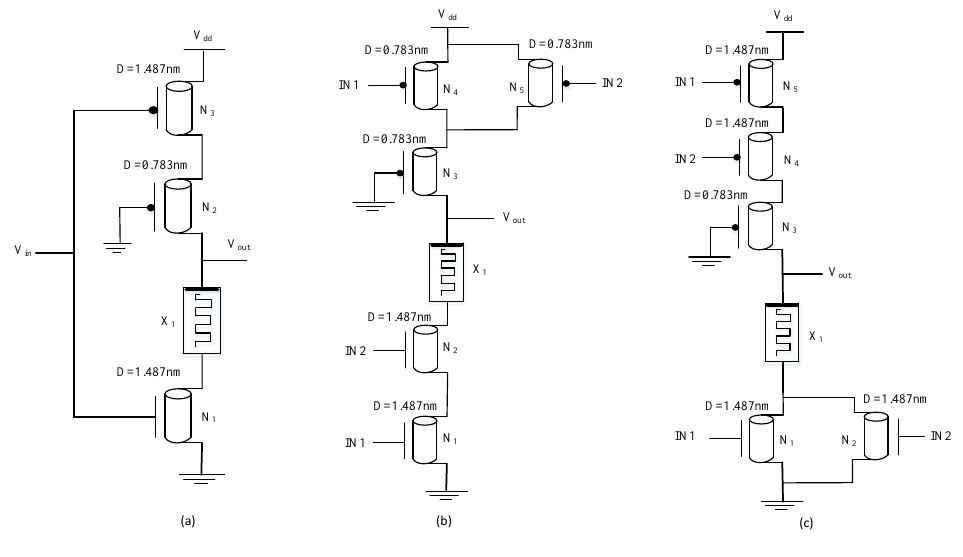
Figure 6. Circuit diagram of ( a ) STI, ( b ) ternary NAND, ( c ) ternary NOR [11]. The ternary CNTFET-RRAM-based Ex-OR gate is designed utilizing the universal property of NAND gates. The circuit schematic of ternary Ex-OR gates using CNTFET- RRAM ternary NAND gates is shown in Figure 7.